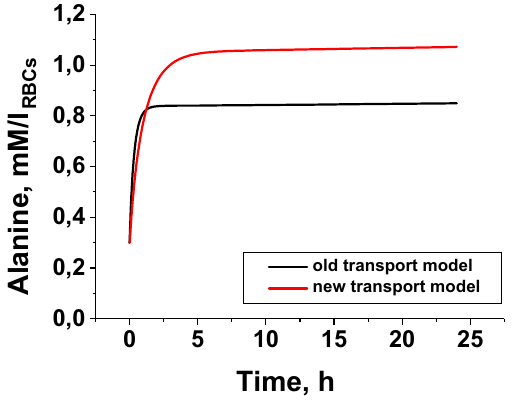
Figure 4. Accumulation of alanine in ammocytes. Theoretical simulation of alanine accumulation inside RBCs during the work of ammocytes, calculated using simplified equations for the alanine and other metabolites transport (black line) 10 and a refined model using equations describing the real transport mechanisms (red line) 22 . Activity of GDH from Proteus sp. and ALT was 8 and 40 IU/ml RBCs , respectively. The ammonium concentration was kept constant at 0.5 mM.